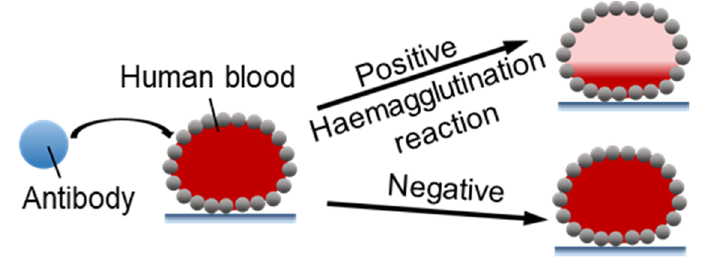
Figure 8. Blood typing using liquid marble-based microbioreactors [83].